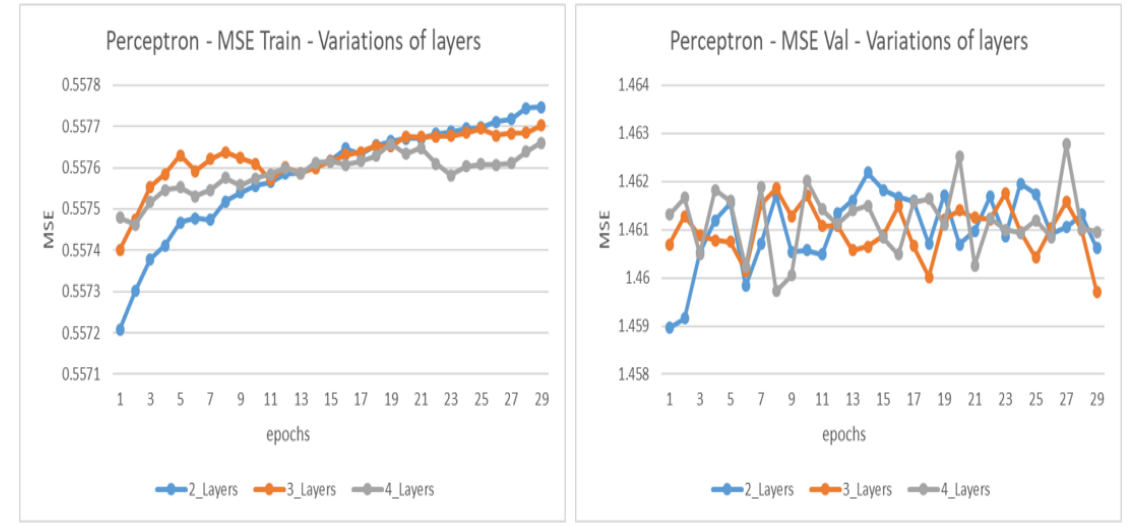
11 of 21 Figure 8. Source: Tests carried out on the variation of layers. Own elaboration.